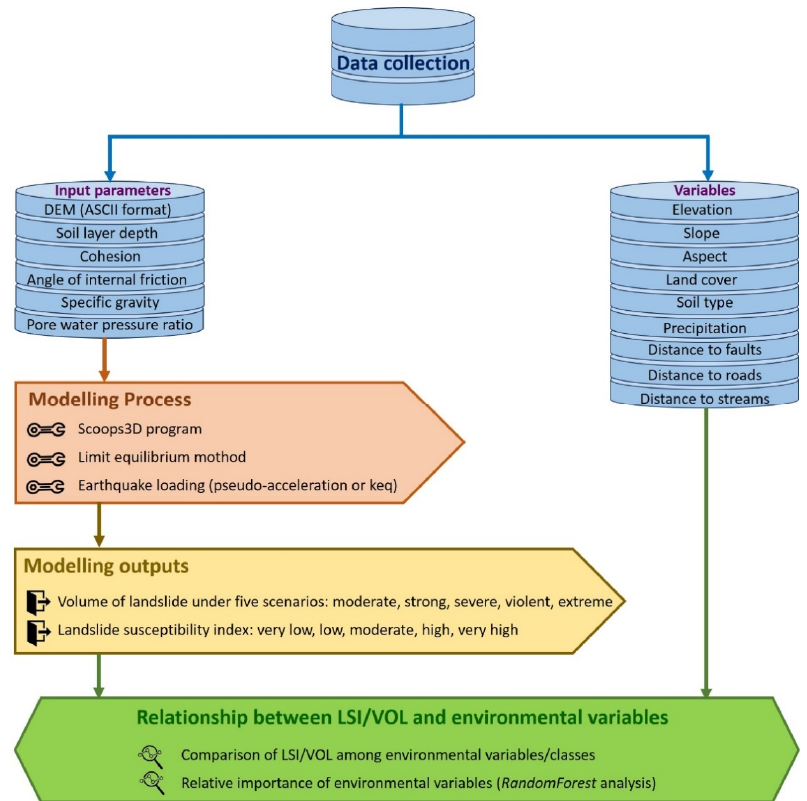
Figure 2. The scheme for the data process and modelling approaches. DEM refers to digital elevation model, ASCII refers to American Standard Code for Information Interchange, LSI refers to landslide susceptibility index, and VOL refers to volume of landslide. Table 1. Input soil parameters for the simulations of Scoops3D in the Mailuu-Suu catchment (adapted from Li et al.